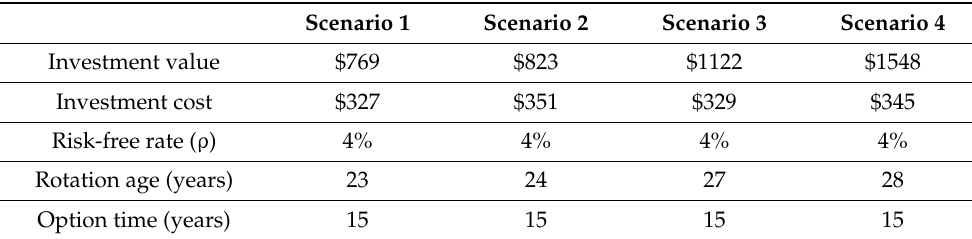
Table 3. Valuation option model